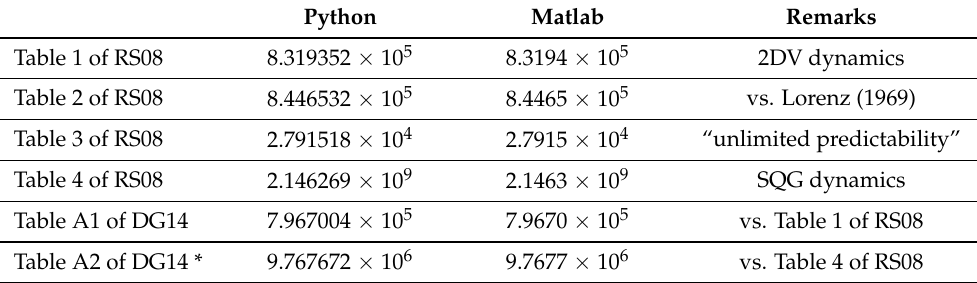
Table 2. Condition numbers in six L69-type systems from Rotunno and Synder (2008, RS08) and Durran and Gingrich (2014, DG14) [32,33]. Both Python and Matlab were used for calculations and displayed similiar